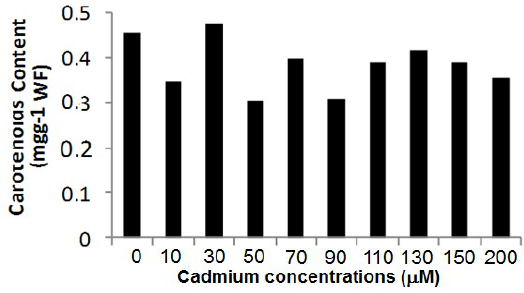
Fig. 10 . Effects of cadmium on carotenoid content of Brassica napus